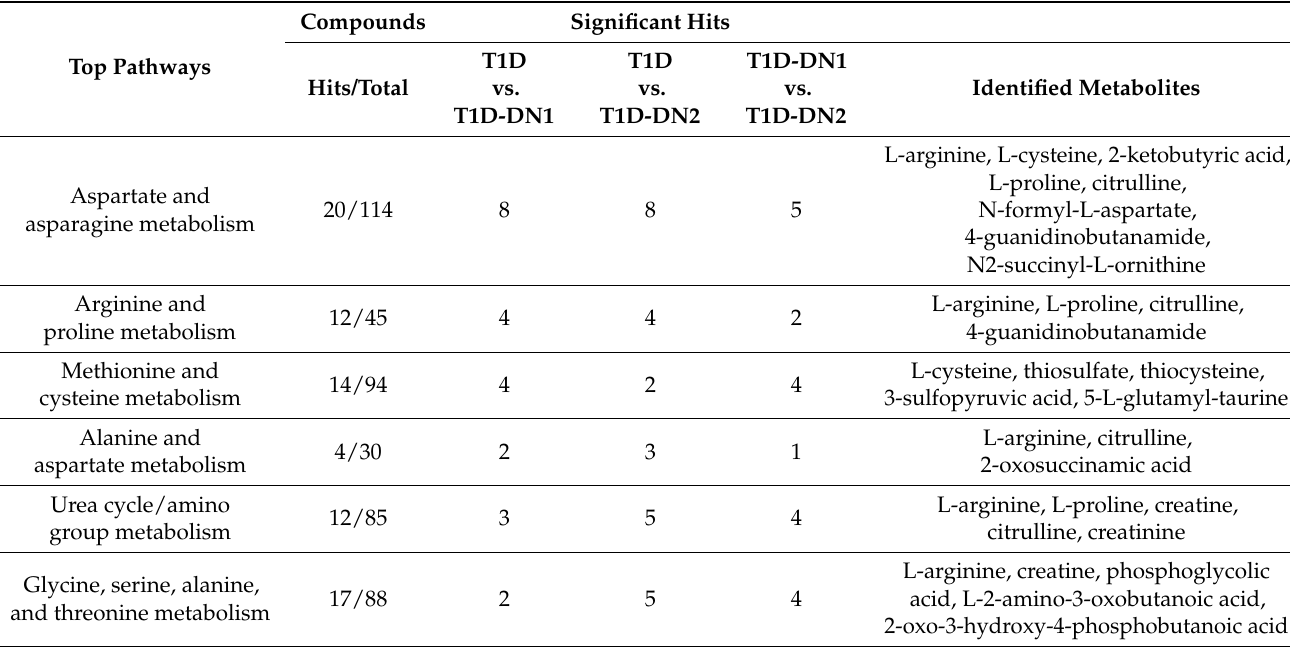
Table S1. The relative abundance of the dysregulated metabolites in the blood plasma samples of the studied participants is shown as a heatmap in Supplementary Figure S1. The top metabolite pathways enriched by the significantly altered metabolites between T1D and T1D-DN1, between T1D-DN1 and T1D-DN2, as well as between T1D and T1D-DN2, are presented in Table 2. Table 2. Top pathways enriched with metabolites characterized by significantly altered abundance in DN, as identified by the functional analysis using